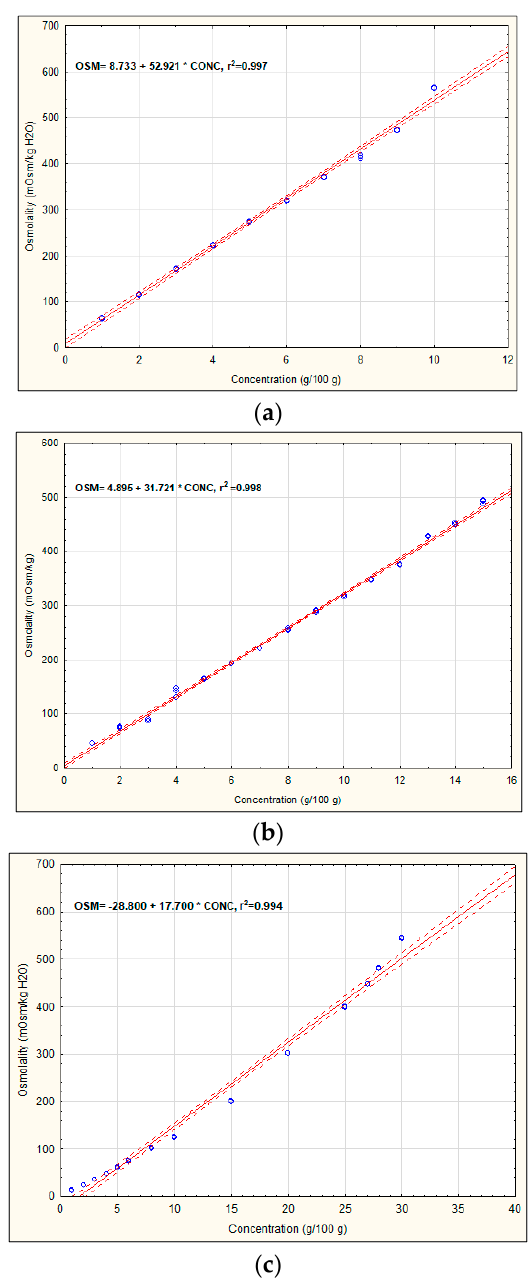
Figure 3. Glucose ( a ), sucrose ( b ), and high-sugar maltodextrin (DE 23–32) ( c ) osmolalities in aqueous solution.